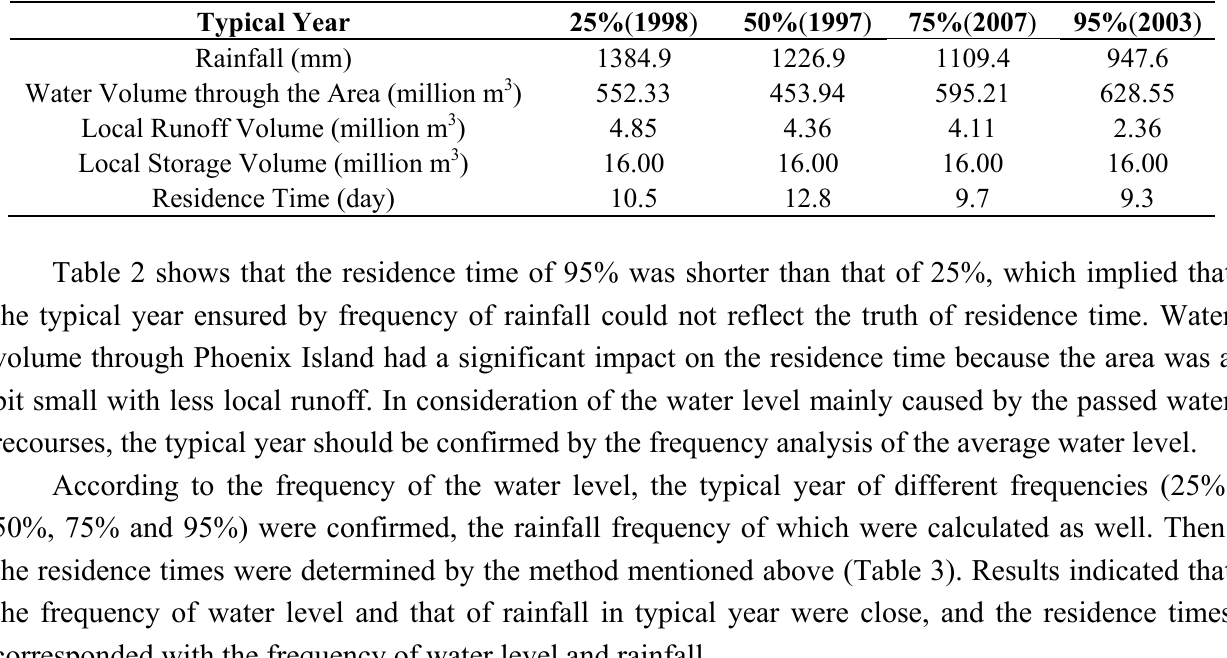
Table 2. Residence times for the typical years ensured by the frequency of rainfall.